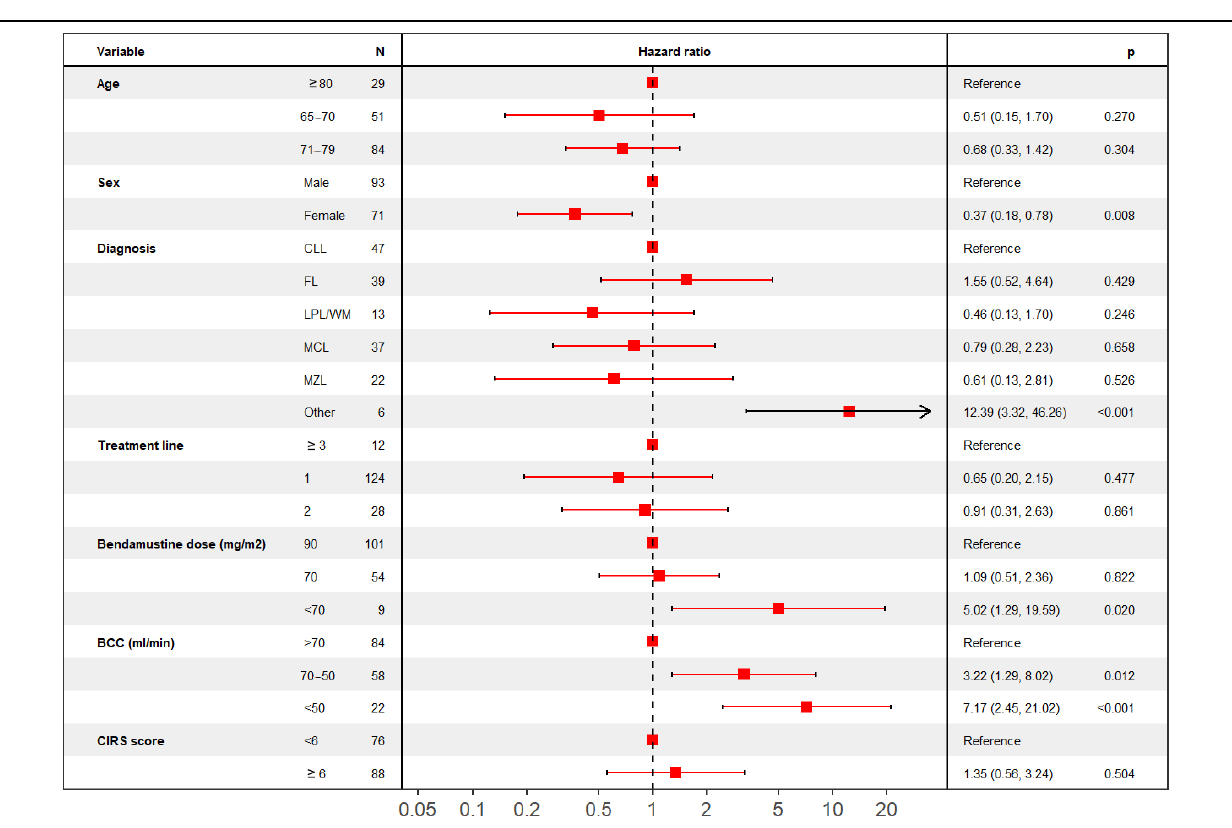
Figure 3. Multivariable analysis for OS. Forest plot describing multivariable analysis results for